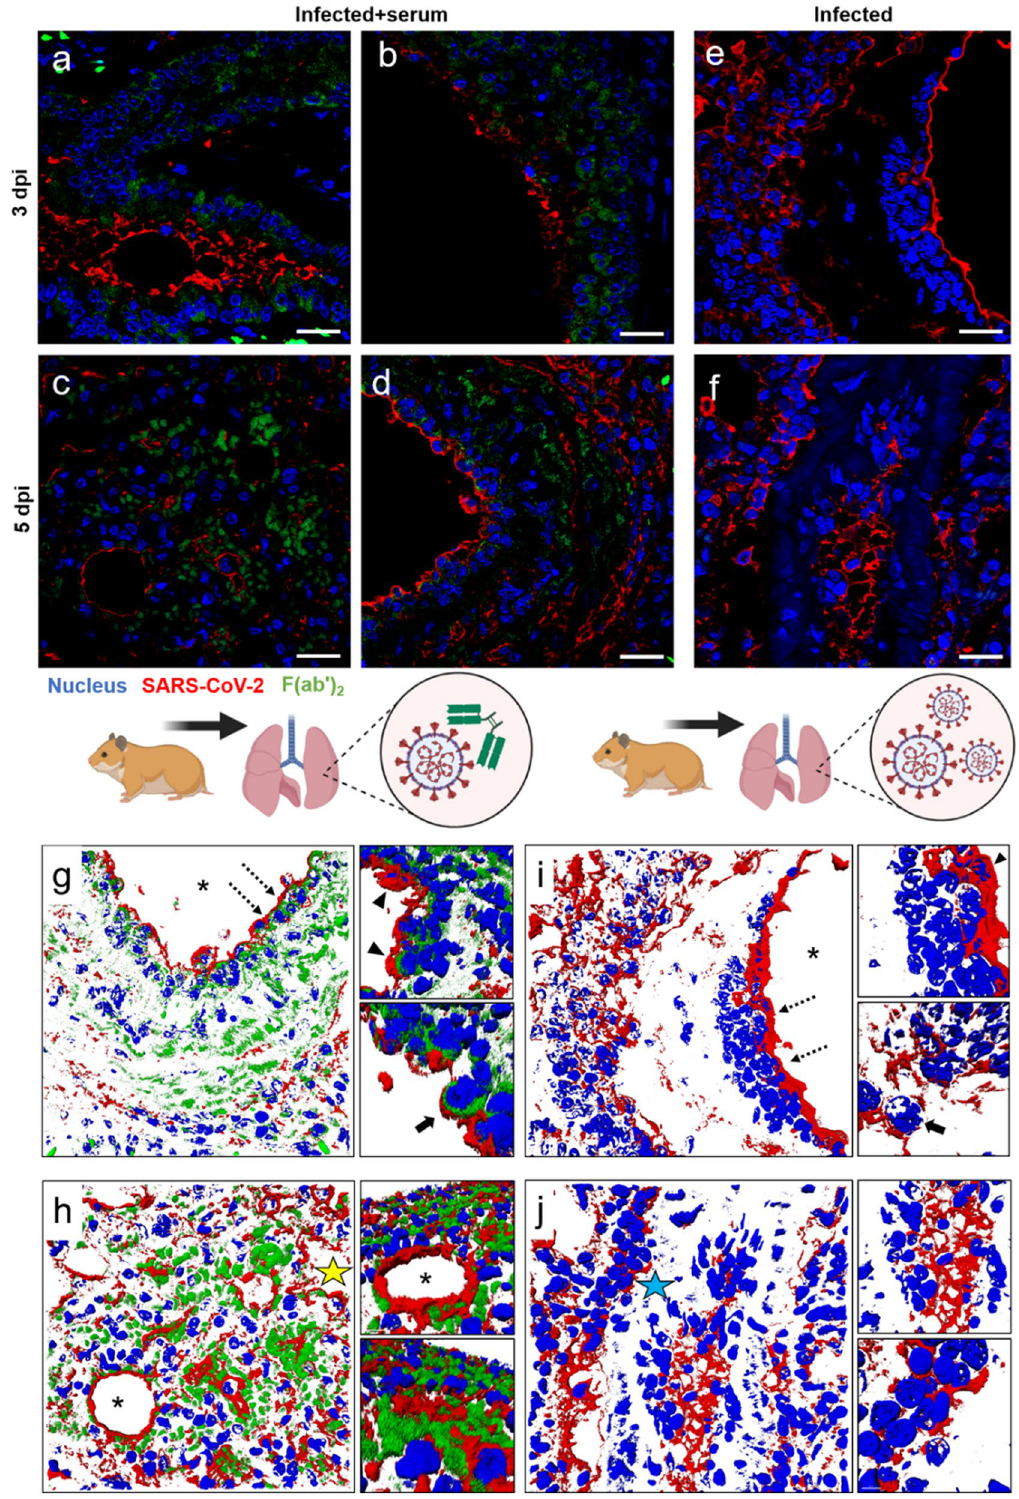
Figure 7. Protective effect of the anti-SARS-CoV-2 antibody on the lungs of the Golden Syrian hamster COVID model. ( a ‒ d ) Positive immunostaining for Spike protein and F(ab ′ ) 2 in lung tissue from infected animals treated with serum. ( g ‒ h ) 3D analysis showing the detailed interaction of SARS-CoV-2 with F(ab ′ ) 2 . ( e ‒ f ) Distribution of SARS-CoV-2 in experimentally infected lung tissue and ( i ‒ j ) 3D infection kinetics. (*) Lumen of the bronchioles or alveoli; (yellow star) interstice; (blue star) vascular endothelium; (dotted arrows) the area of highest magnification to the right; (arrowhead) regions of viral adhesion and antibodies; (arrow): protective effect of F(ab ′ ) 2 on a bronchial epithelial cell or just infected cell. Bar: 20